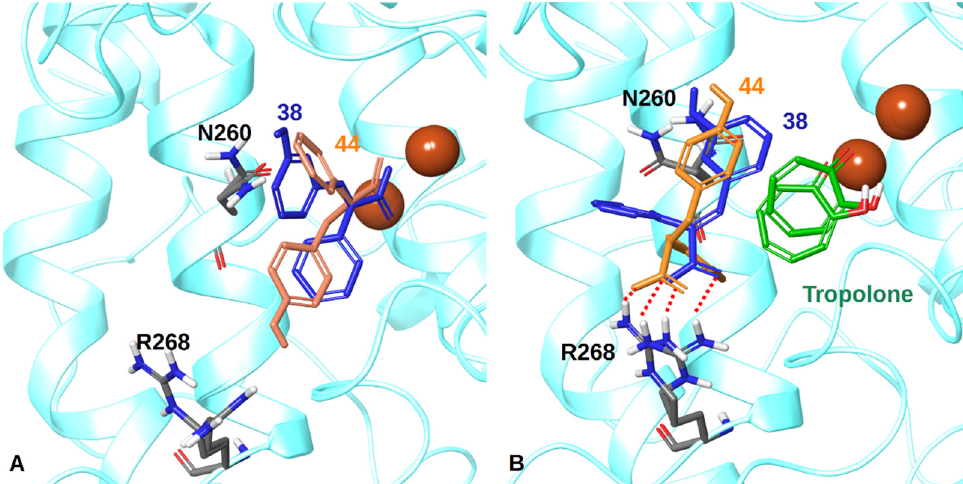
Figure 4. The binding mode of compounds 38 and 44 using the crystal structure of tyrosinase (PDB entry 2Y9X) in the absence ( A ) or the presence ( B ) of the crystallographic ligand. entry 2Y9X) in the absence ( A ) or the presence ( B ) of the crystallographic